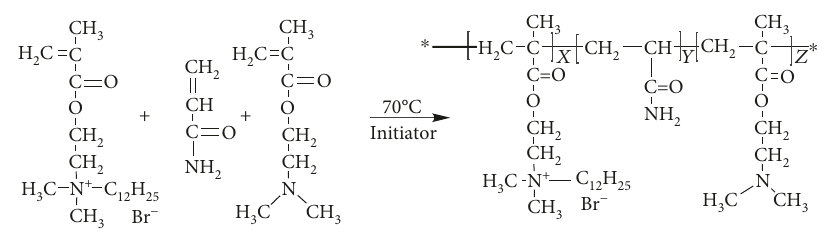
Figure 2: Schematic of synthesis of P(AM-DM-DMC12).